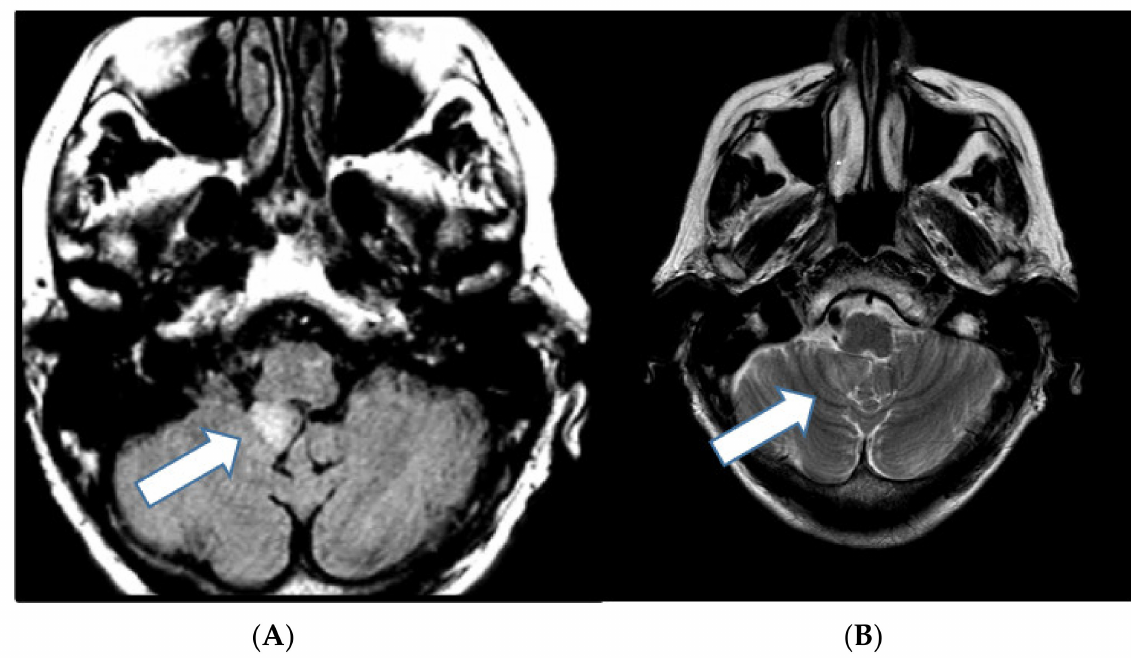
Figure 3. A 66-year-old woman with a history of clinical Cowden syndrome and pathologic PTEN -mutation-associated meningioma presenting with headache. ( A ) Axial FLAIR magnetic resonance image demonstrates a hyperintense oval mass measuring 13 mm at the inferior right cerebellum (arrow), encroaching on the fourth ventricle. ( B ) T2-weighted images demonstrate classic “tigroid” appearance representing dysplastic gangliocytoma (Lhermitte–Duclos